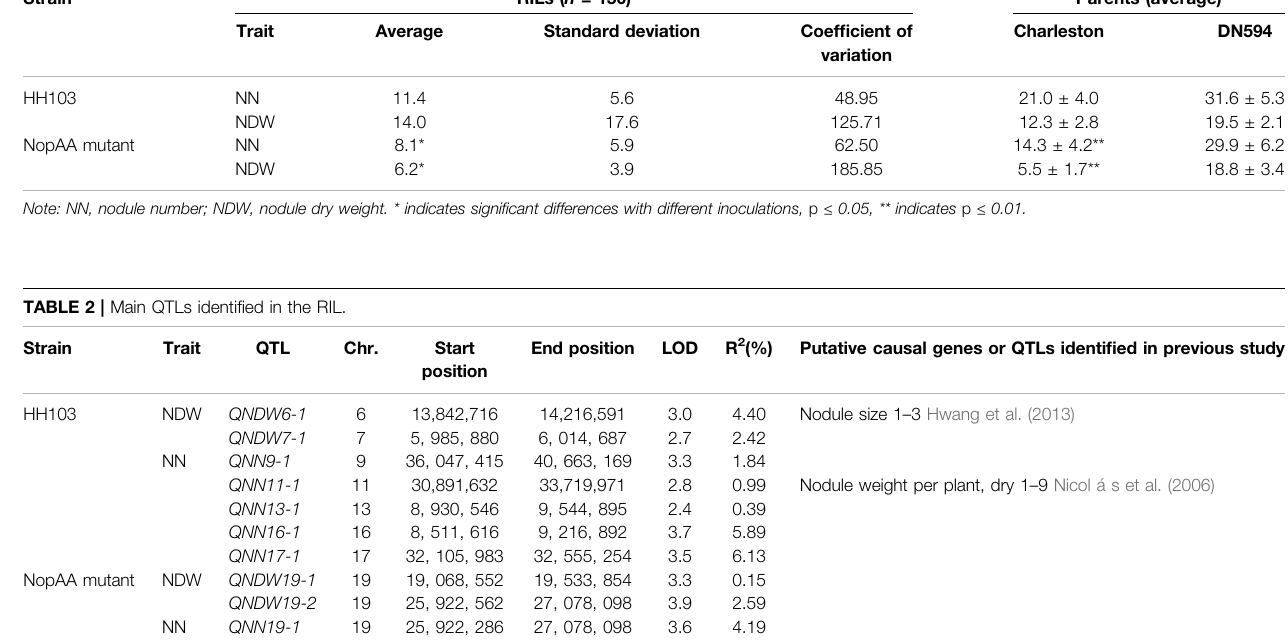
TABLE 1 | Nodule traits in RILs inoculated with HH103 and HH103 Ω NopAA. Strain RILs ( n = 150) Trait